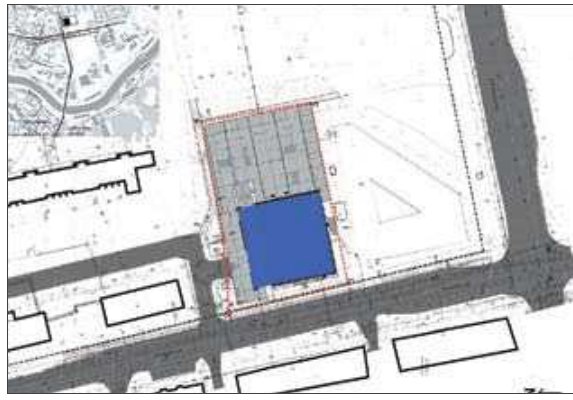
9 pav. Prokuratūrų pastatas (generalinis planas), Vilnius. archit. k. Lupeikis, 2006 m. Fig 9. Prosecutor's Office building (General Plan), Vilnius.